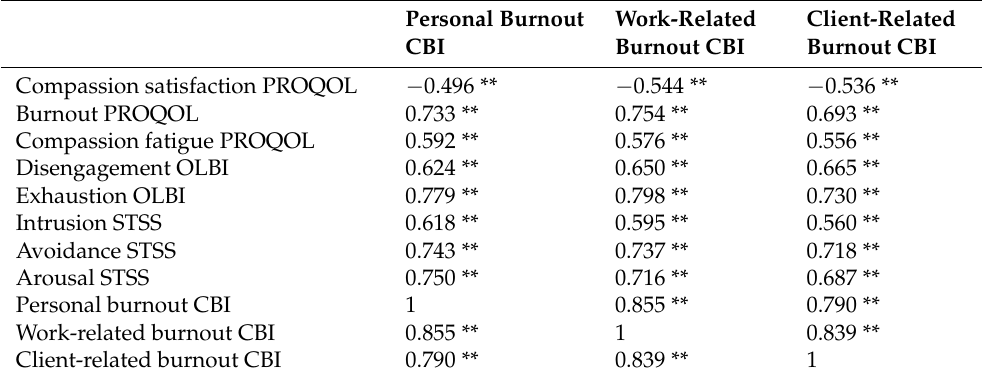
Table 3. Spearman correlations between the CBI subscales and the PROQOL, OLBI, and STSS subscales.